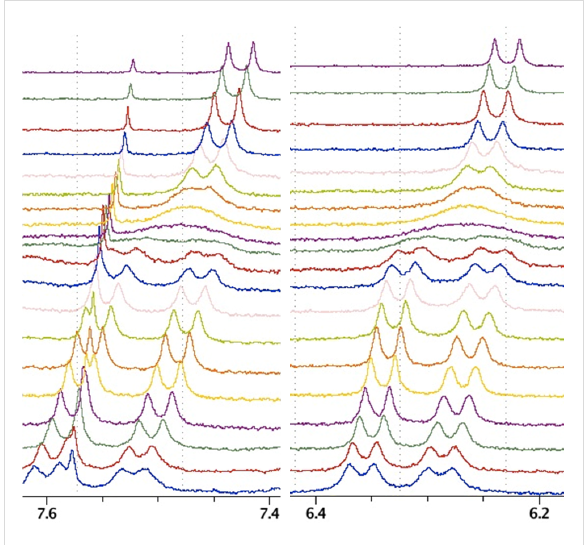
calculated and their energetic relations are in agreement with observed data (see data in Supporting Information File 1 and Figure S34 for the energy diagram).